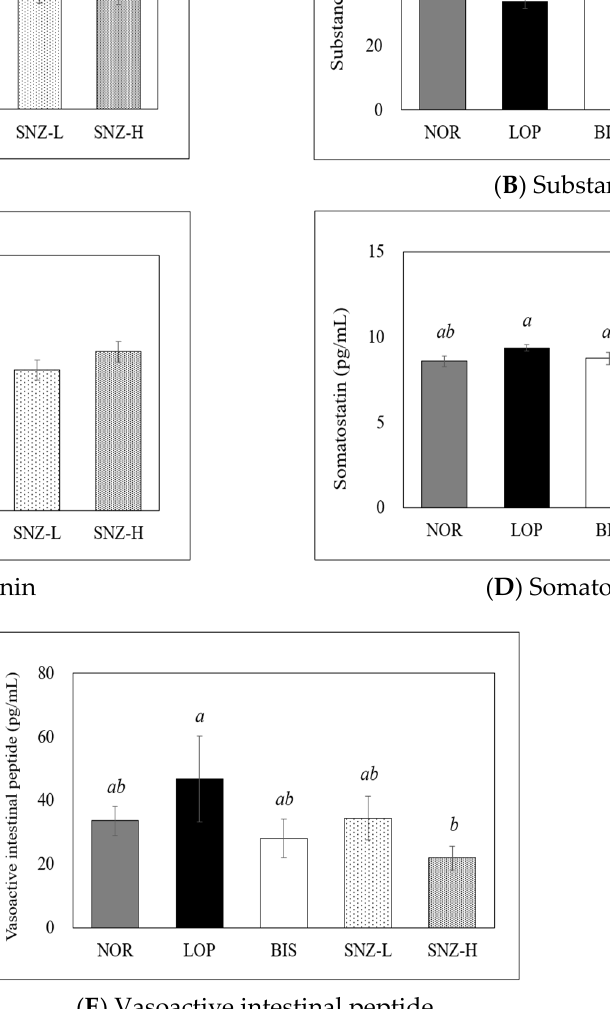
Figure 6. Effects of B. coagulans SNZ 1969 on plasma gastrointestinal hormones in loperamide-induced constipation rats. NOR: Normal group, LOP: Loperamide treated group; BIS: Loperamide and Bisacodyl 8 mg/kg treated group; SNZ-L: Loperamide and B. coagulans SNZ 1969 at 1 × 10 8 CFU/day treated group; SNZ-H: Loperamide and B. coagulans SNZ 1969 at 1 × 10 10 CFU/day treated group. Concentrations of ( A ) Gastrin, ( B ) Substance P, ( C ) Cholecystokinin, ( D ) Somatostatin, and ( E ) Vasoactive intestinal peptide in plasma were estimated by ELISA. The results are presented as mean ± SE (n = 8). Means with the different letters above a bar are significantly different at p < 0.05 by Duncan’s multiple range test. NS: not significant.